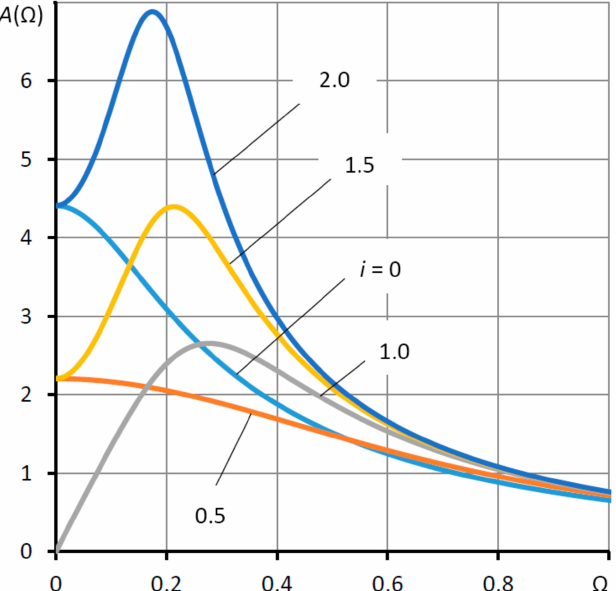
Figure 11. Amplitude–frequency characteristics of the thrust bearing at the “calculated point” for different values of the elasticity coefficient K e = i K e 0